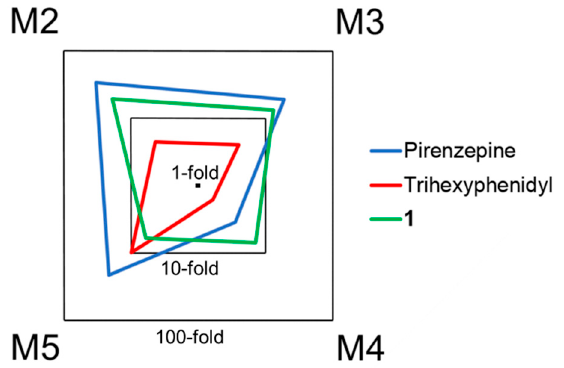
Figure 5. Subtype selectivities related to M1 visualized as radar charts. For each substance, the logarithmic axis represents K i toward the respective subtype divide by the K i of M1. Compared to the clinically established M1 antagonists pirenzepine and trihexyphenidyl, 1 shows a pronounced subtype selectivity toward M4, which results in overall broader subtype selectivity. Selectivities of pirenzepine and trihexyphenidyl were calculated based on their literature reported K i values [23].